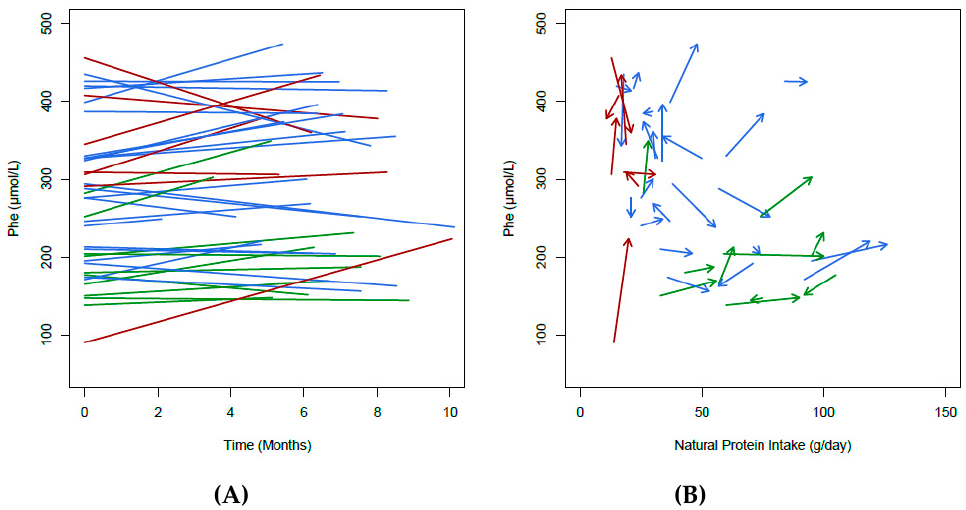
Figure 1. ( A ) Change in blood Phe ( µ mol / L) over time with fitted regression line and ( B ) pairwise change in blood Phe ( µ mol / L) and total natural protein (g / day) intake between assessments. Red lines denote subjects with classical PKU, blue lines denote subjects with mild PKU and green lines denote subjects with HPA.